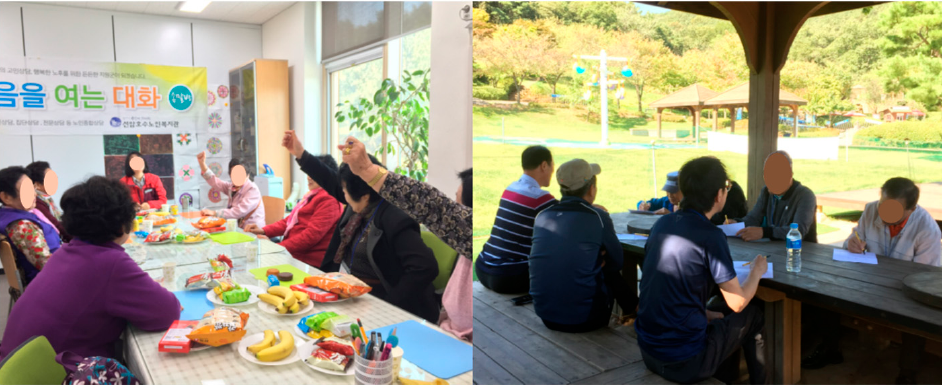
Figure 2. Group activities in Befriending (left) and Colourful Youth (right).